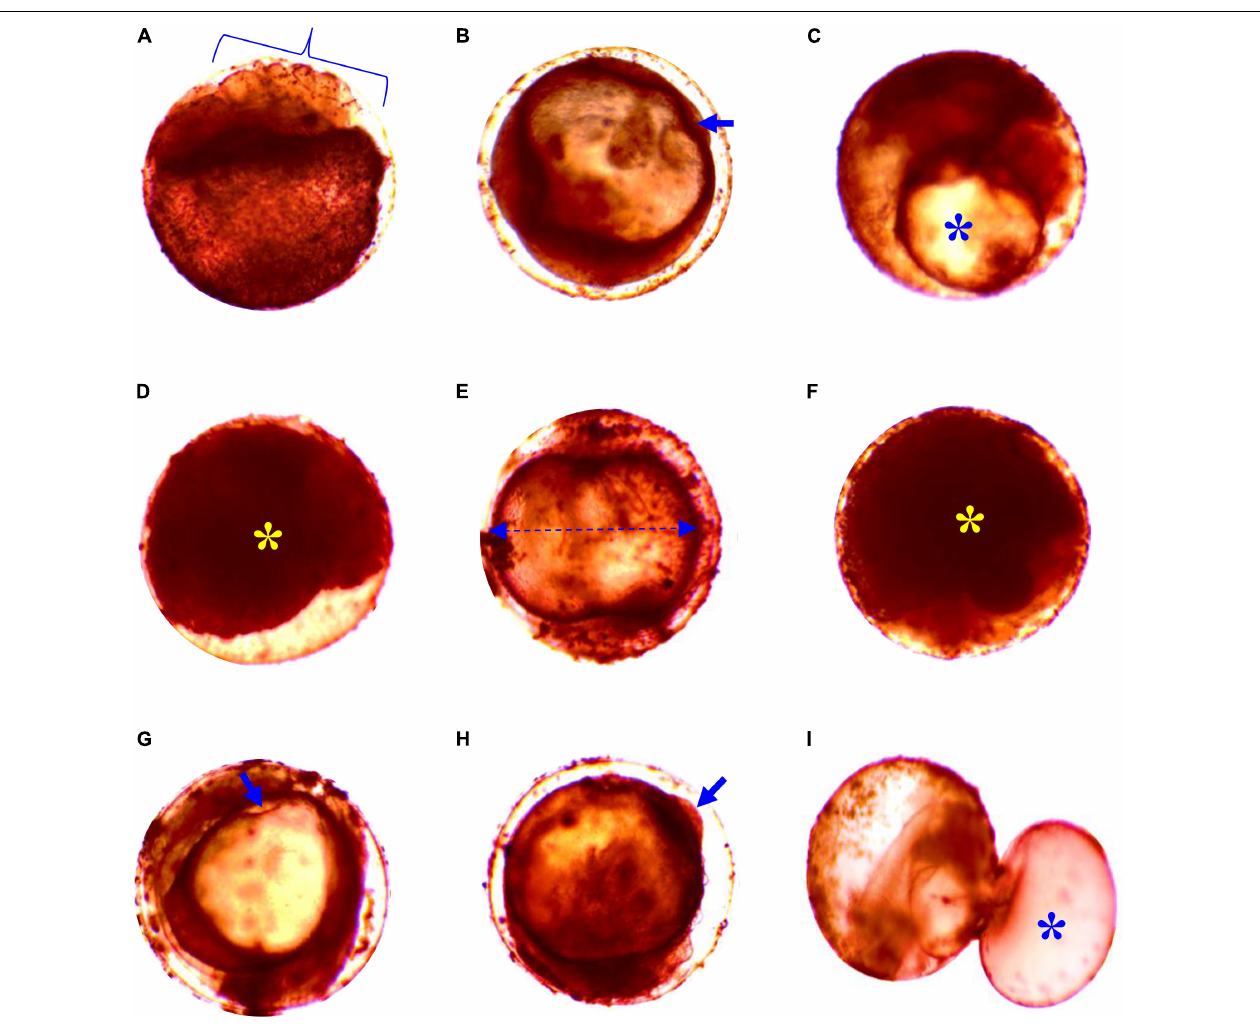
FIGURE 1 | Deformities in embryos of striped catfish exposed to different salinities; (A) cell deformities and damaged at 6 ppt salinity after1 h 47 min, (B) no detachment of tail at 8 ppt salinity after 3 h (arrow), (C) undeveloped yolk sac at 10 ppt salinity after 3 h 58 min (asterisk), (D) coagulated embryo in glyphosate at 10 ppt salinity after 12 h 48 min (asterisk), (E) gastrula yolk sac elongated shape and lack of heartbeat at 4 ppt salinity after 15 h 15 min (arrow line), (F) agglutination of the embryo at 4 ppt salinity after 18 h 10 min (asterisk), (G) streaks within the chorion at 6 ppt salinity after 15 h 15 min (arrow), (H) cleavage yolk sac bud/snowball at 6 ppt salinity after 16 h 15 min (arrow), and (I) embryos swelling/pustule at 8 ppt salinity after 27 h 35 min (asterisk). Scale bar = 40 µ